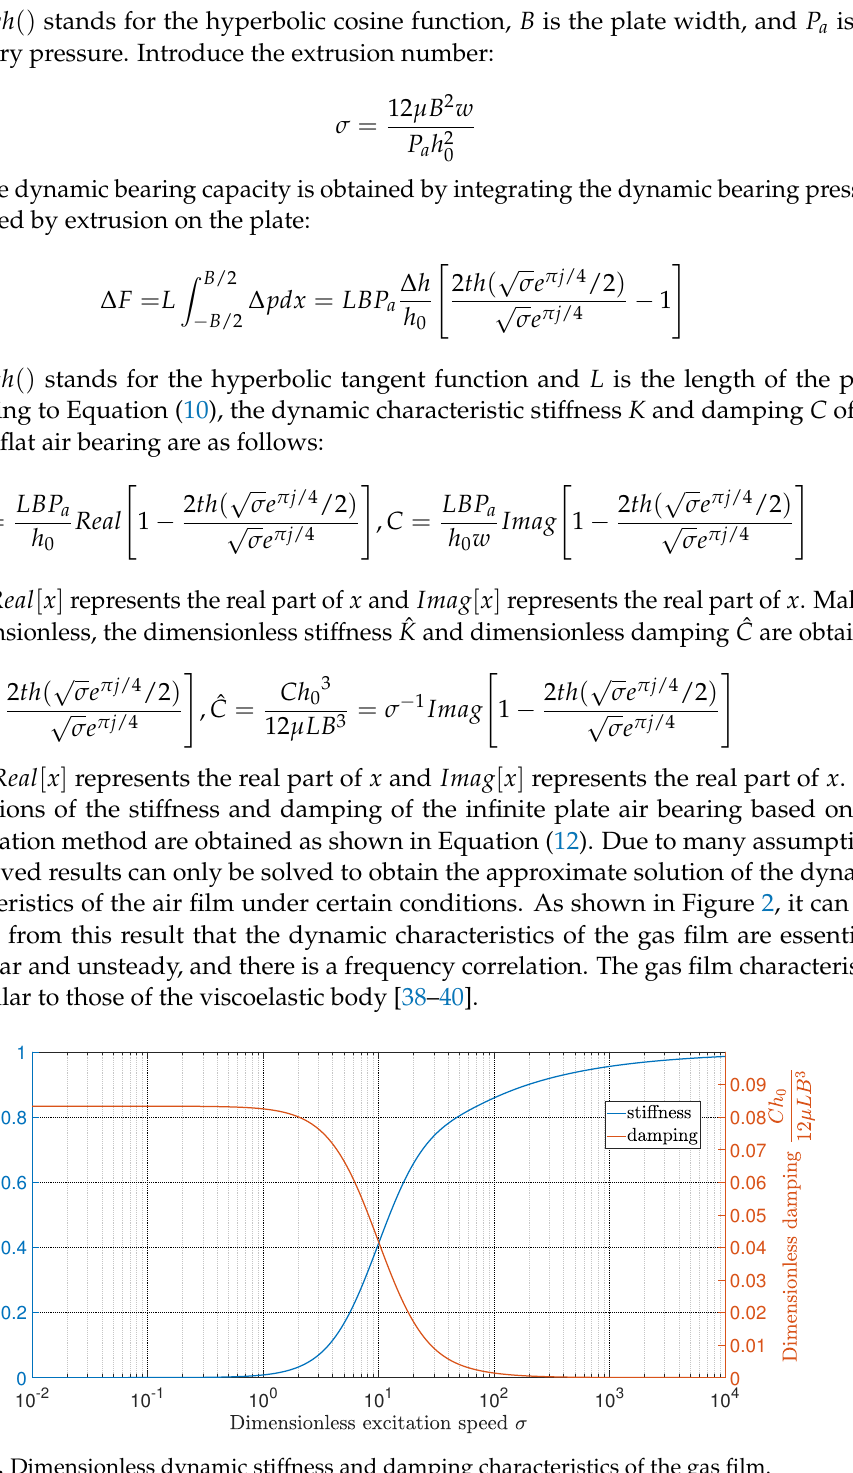
Figure 2. Dimensionless dynamic stiffness and damping characteristics of the gas